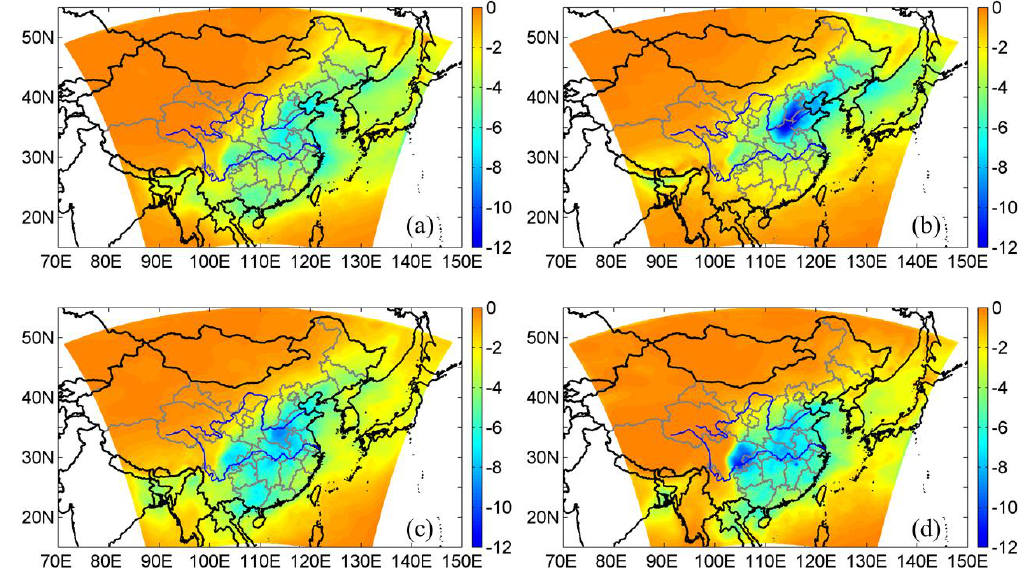
Figure 4. Seasonal mean direct radiative forcing (DRF) due to nitrate at the top of the atmosphere (TOA) under all-sky condition for ( a ) spring; ( b ) summer; ( c ) autumn; and ( d ) winter in 2010.